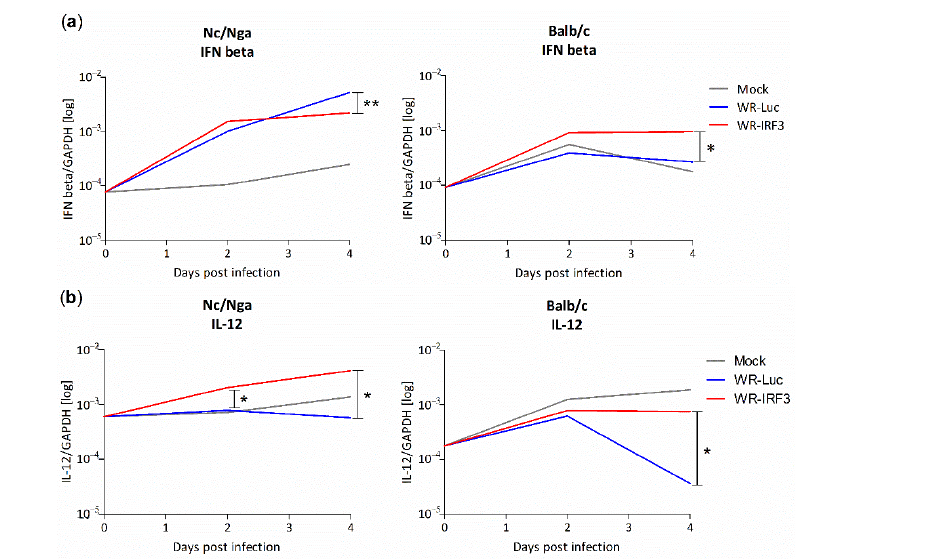
Figure 7. Changes in IFN β and IL-12 mRNA levels in mouse skin lesions. Nc/Nga and Balb/c mice were t.d. inoculated with PBS or 7.5 × 10 5 PFU/mouse of purified WR-Luc or WR-IRF3, sacrificed at indicated days p.i. and RNA from skin lesions was used for 1-step RT-qPCR analysis. ( a ) IFN β and ( b ) IL-12 mRNA was normalized to GAPDH mRNA. Graphs represent geometrical means, n = 3 mice/group. Statistically significant differences at * p < 0.05, ** p < 0.01 (two-tailed unpaired Student’s t-test). See Figure S5 for further details. In Balb/c mice, levels of most mRNAs studied increased in mock-infected mice at 2